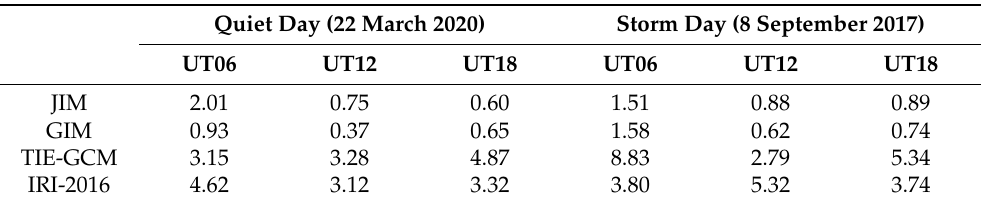
Table 1. RMSEs of the JIM, GIM, TIE-GCM and IRI-2016 at UT06, UT12 and UT18 under quiet and severe geomagnetic days. Reference: GNSS-TEC.